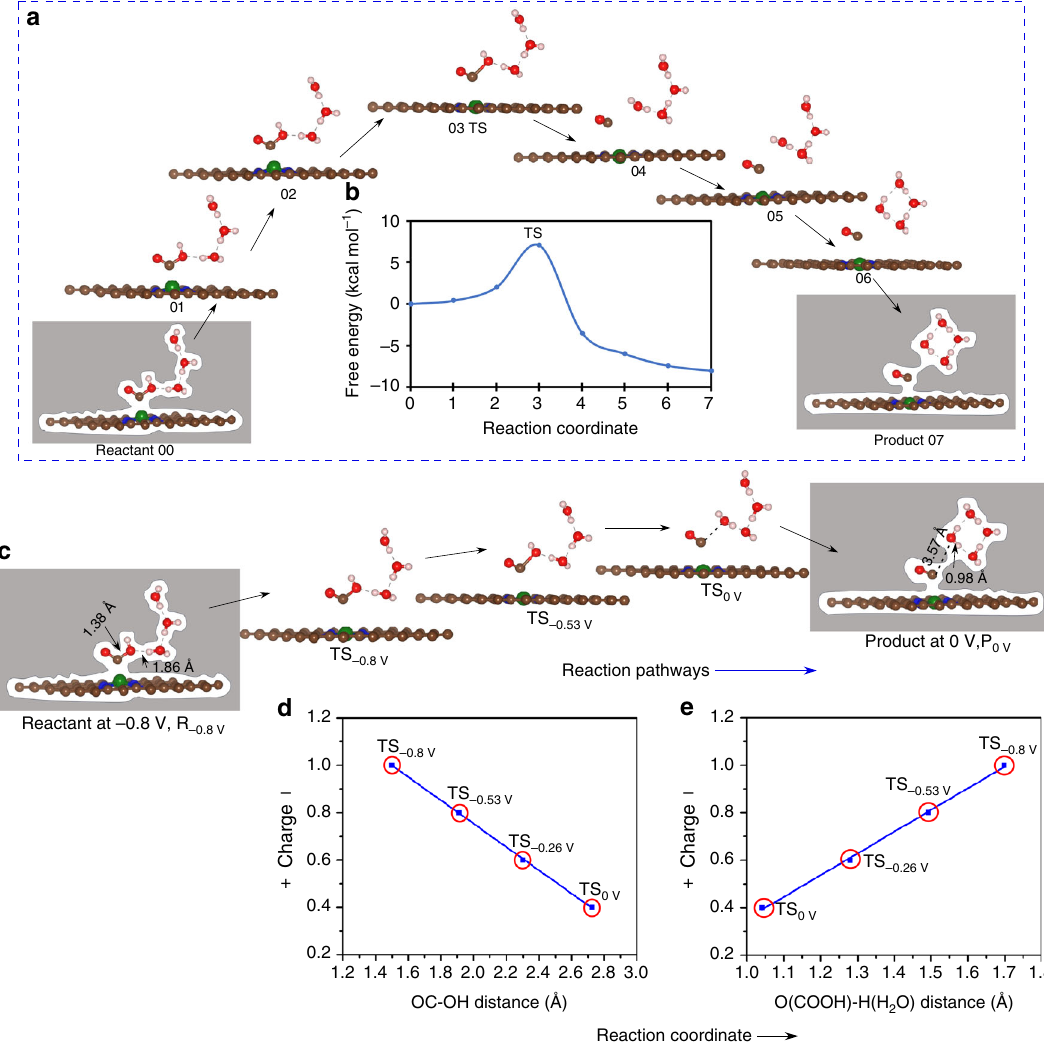
Fig. 4 COOH to CO reaction pathways and transition states at different potential. a The minimum energy path (MEP) for cis-COOH to CO conversion at − 0.53 V applied potential (0.8 charge) on Ni – N – 07) for this conversion process. During the reaction of cis- 4 site. We use a total of eight images (00 COOH with water, the OC – OH bond length increases from 1.38 to 1.86 Å with a transition state (TS) at image 03. Eventually it forms CO by breaking OC – OH bond. The arrow indicates the forward direction of the reaction via MEP. b The free energy barrier for the cis-COOH to CO at − 0.53 V applied potential via MEP. Image 03 (TS) shows the maximum energy barrier of 7.02 kcal mol − 1 at − 0.53 V applied potential for the conversion of cis-COOH to CO on Ni – N 4 site. c The transition state (TS) between reactant cis-COOH and product CO changes with applied potential. Staring from product, at zero applied potential the product (P 0V ) CO is 3.57 Å (OC – OH) distance away from neighboring water while the O – H bond distance in water is 0.98 Å. The transition state at zero (TS 0V ) applied potential shows a geometry similar to the product. At − 0.53 V applied potential, the OC – OH distance at the transition state (TS − 0.53V ) decreases while the O-H bond increases. With a more negative applied potential of − 0.8 V, the OC – OH bond of the transition state (TS − 0.8V ) becomes very early, closer to the reactant at same potential. The reactant at − 0.8 V (R − 0.8V ) has OC – OH = 1.38 Å and O – H = 1.86 Å. The arrow indicates the reactant to product direction. d The relation of distance between OC – OH to the fractional charge in the TS as a function of applied potential. e The change of distance between O-H and the fractional charge in the TS as a function of applied potential. The red circle represents the TS at different applied potentials. (Gray color: entire surface represents implicit solvation along the whole reaction pathways, brown: carbon, blue: nitrogen, green: nickel, red: oxygen, off white: hydrogen